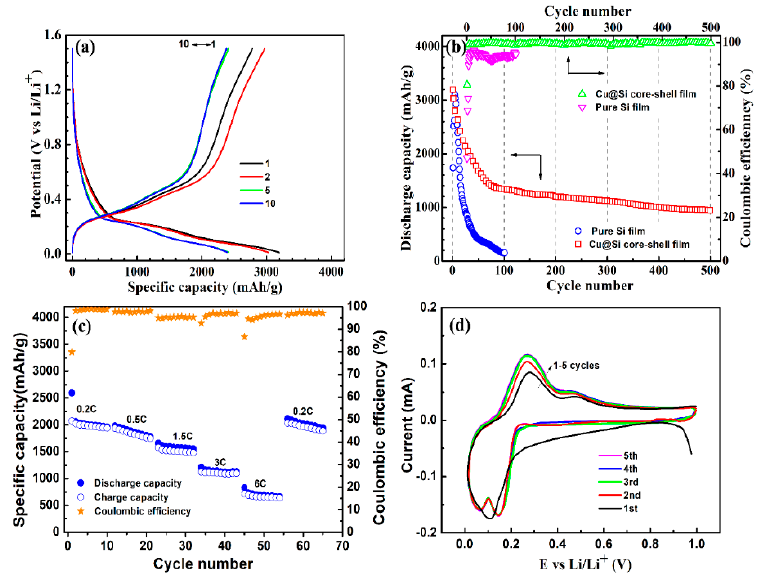
Figure 3. ( a )Voltage profile of the Cu@Si CSNWFs at the 1st, 2nd, 5th, and 10th cycle at a current rate of 0.1 C between 0.01 and 1.5 V; ( b ) the specific discharge capacity and coulombic efficiency of the Cu@Si CSNWFs and pure Si films as a function of cycle number at a rate of 0.16 C between 0.01 and 1.5 V; ( c ) the specific discharge capacity of Cu@Si CSNWFs as a function of the cycle number and current rate; ( d ) cyclic voltammetry curves of the Cu–Si core–shell nanowires embedded Si thin films (CSNEFs) in the potential range of 0.01–1.2 V at a scan rate of 0.2 mV s − 1